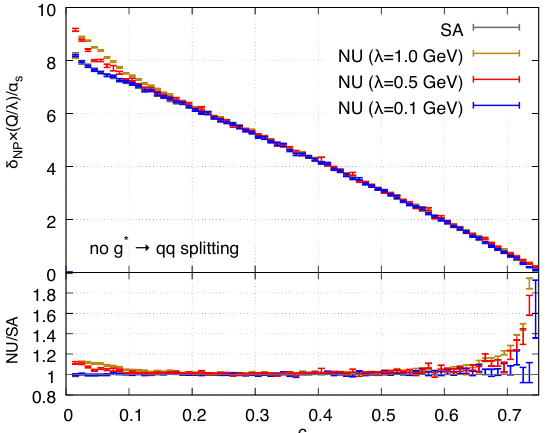
Figure 2 . The non-perturbative shift δ NP for the C -parameter defined in eq. (4.26), stripped of the λ/Q and α factor, computed with the semi-analytic result of eq. (4.26) (labeled SA), and using s the numerical implementation of eq. (5.34) (labeled NU). The splitting g ∗ → q ¯ q is not included. For the numerical calculation, we use Q = 100 GeV and three different values of λ